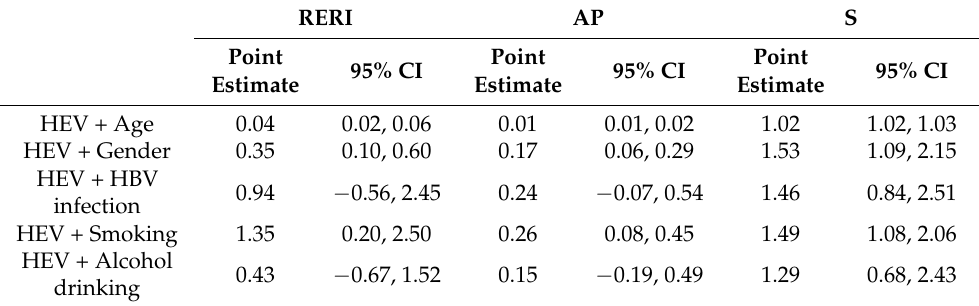
Table 4. The additive interactions between HEV and other cancer risk factors among all can- cer